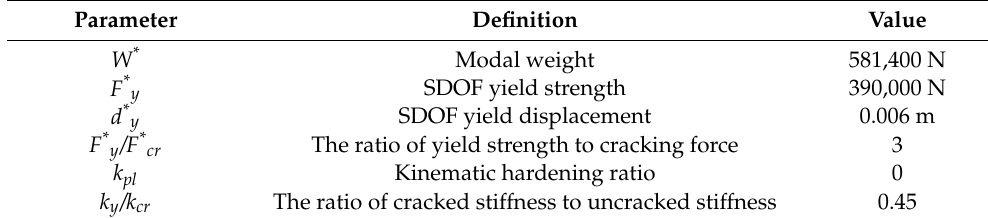
Table 2. Parameters of HHS model.